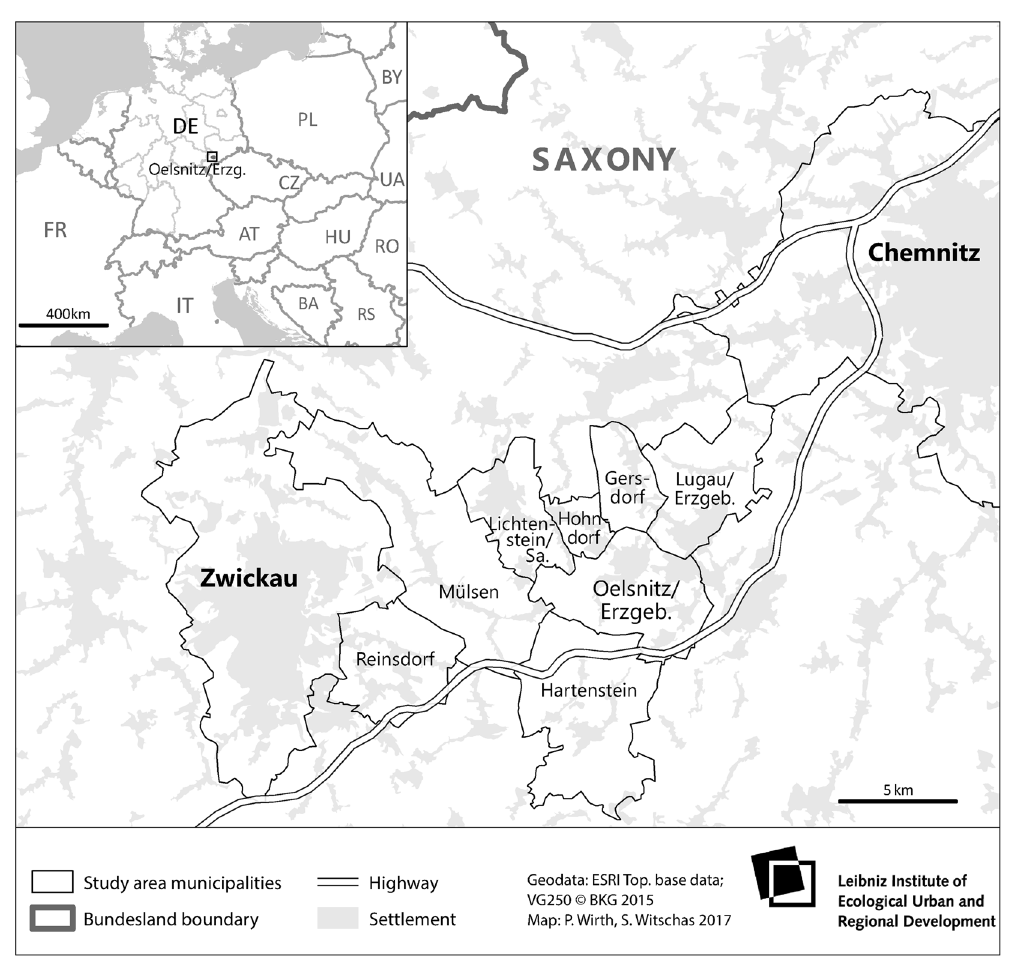
Fig. 1 Study area of